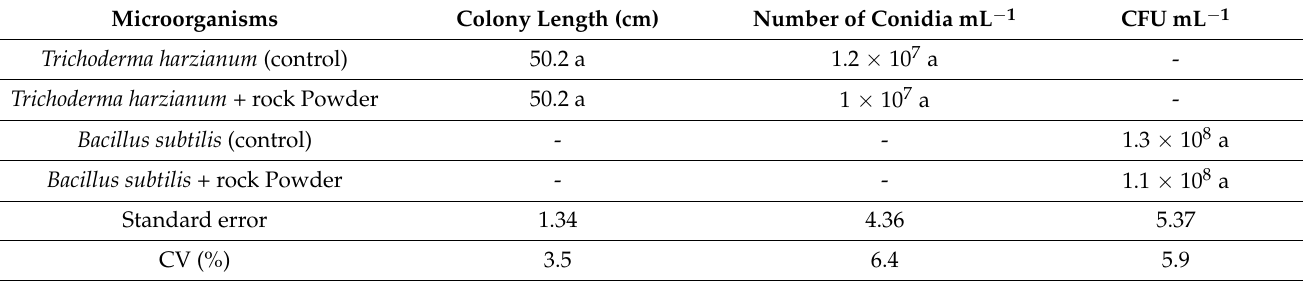
Table 1. Compatibility analysis of rock powder with the microorganisms Trichoderma harzianum and Bacillus subtilis